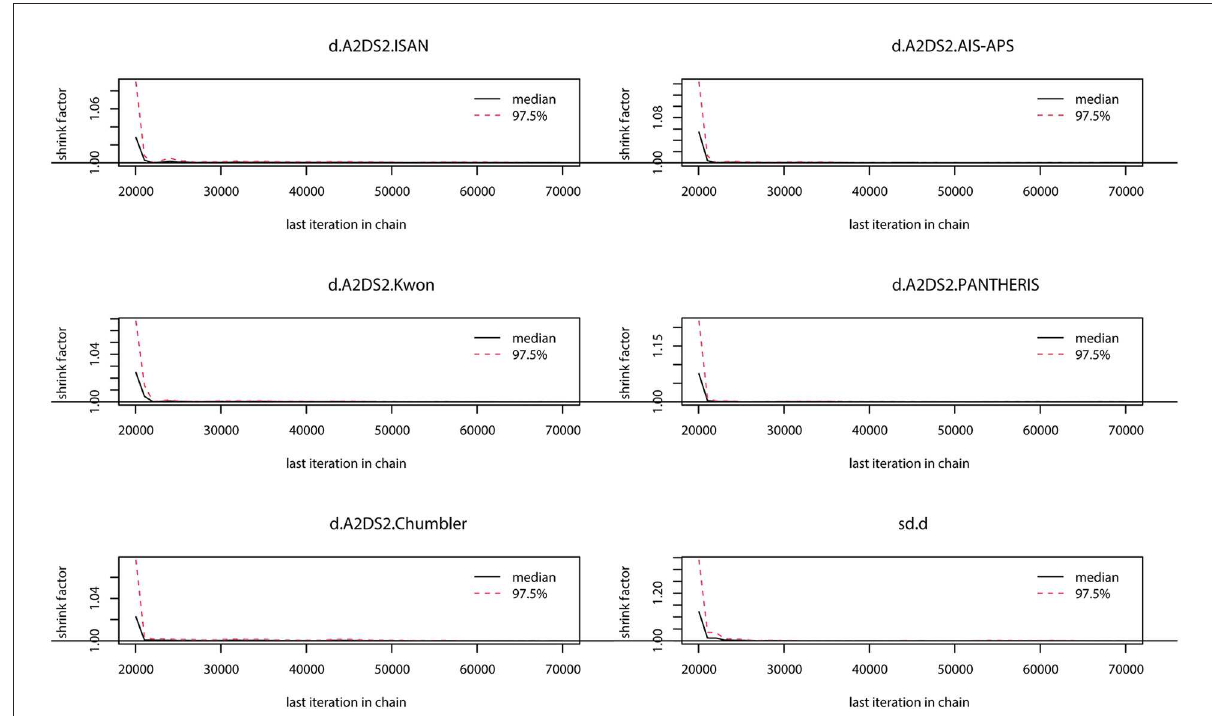
FIGURE4 Convergence diagnosis graph. The value of the potential scale reduction factor (PSRF) tends to 1 indicating a satisfactory degree of model convergence.